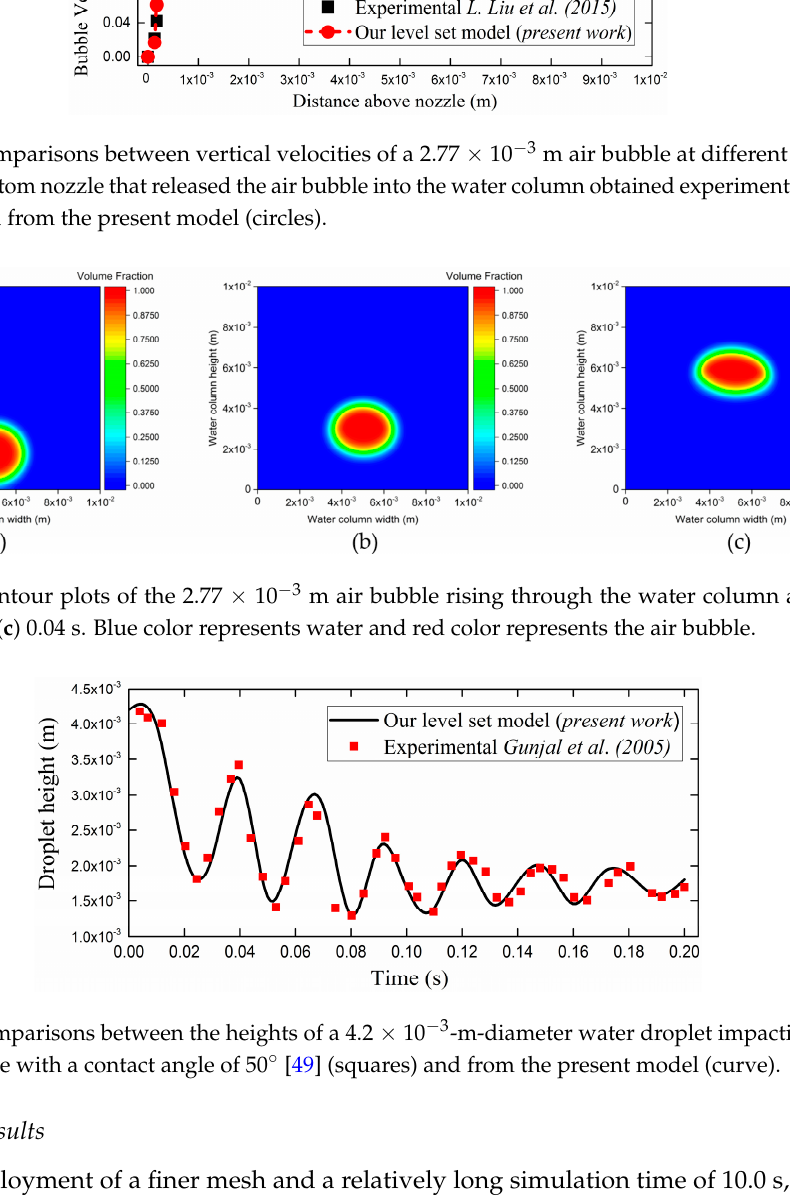
Figure 8. Average velocity magnitude of the mixture of fluids over the mixing chamber domain with and without obstacles (Note: the mixing chamber domain is marked in blue).